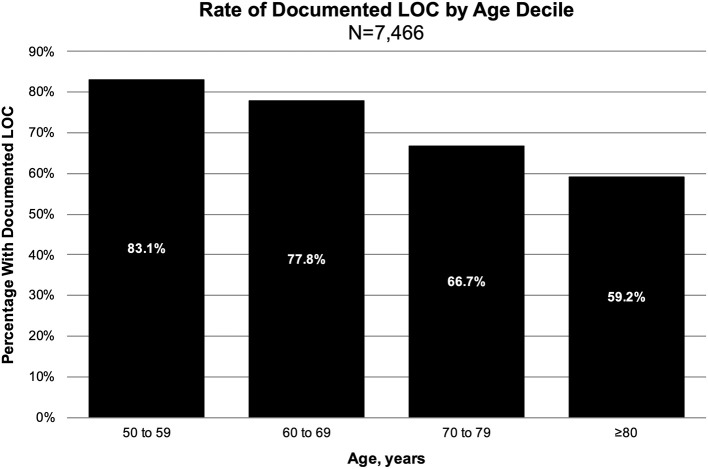
Risk of loss of consciousness by age decile.